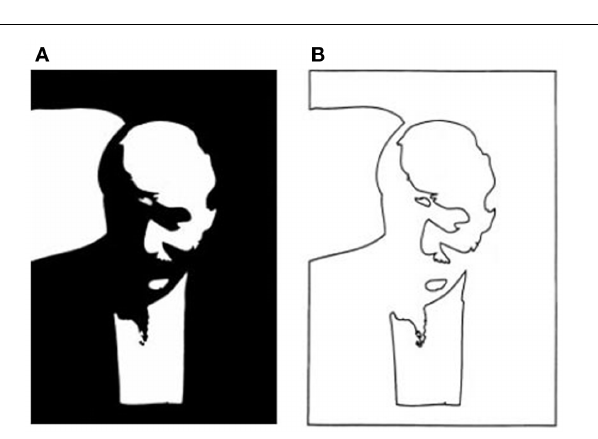
FIGURE 1 | (A) Early line drawing representation of a rhinoceros at Chauvet, France, ca 30,000 BCE. (B) Outlines are infrequent effects of backlighting in natural scenes but even in this case, internal contours are never visible as lines. (C) Bio-mimicry used by the Fulgorida of South and Central America where lines trace the contour between the simulated lips and mouth. (D) Lines typically stand for discontinuities in surface depth or orientation but some artists rely on cultural conventions to make them stand for motion or energy (Keith Haring).